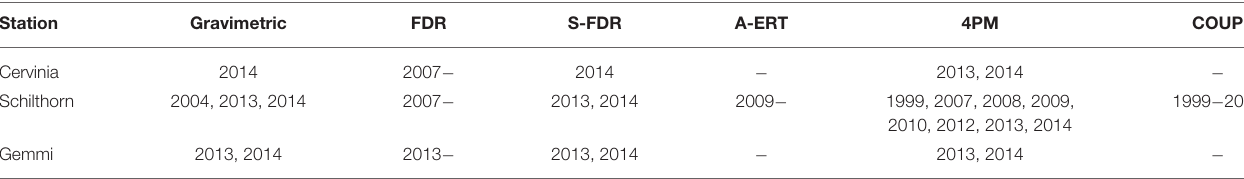
TABLE 1 | Summary of the relevant data available at Schilthorn, Cervinia, and Gemmi. Station Gravimetric FDR S-FDR A-ERT 4PM COUP Cervinia 2014 2007 − 2014 −